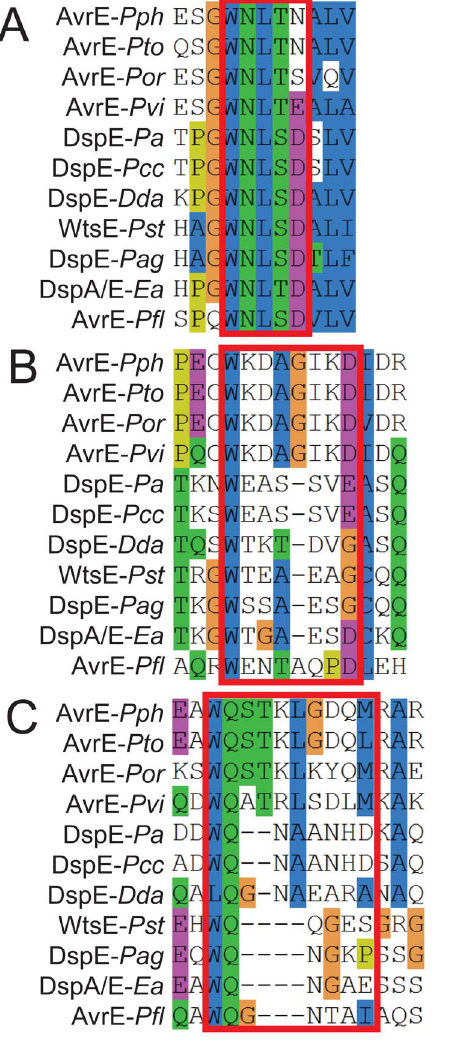
Figure 5. Multiple sequence alignment with hierarchical clustering of DspE homologs in plant pathogenic bacteria. A. W464, B. W514, C. W660 in P. carotovorum WPP14 protein sequence. Dashes indicate gaps. Genus and species abbreviations and protein names are as follows Pph ( Pseudomonas syringae pv. phaseolicola 1448A, NCBI Ref. Seq. YP_273527.1), Pto ( Pseudomonas syringae pv. tomato DC3000, NCBI Ref. Seq. NP_791204.1), Por (Pseudomonas syringae pv. oryzae, NCBI Ref. Seq. ZP_04588443.2), Pvi ( Pseudomonas